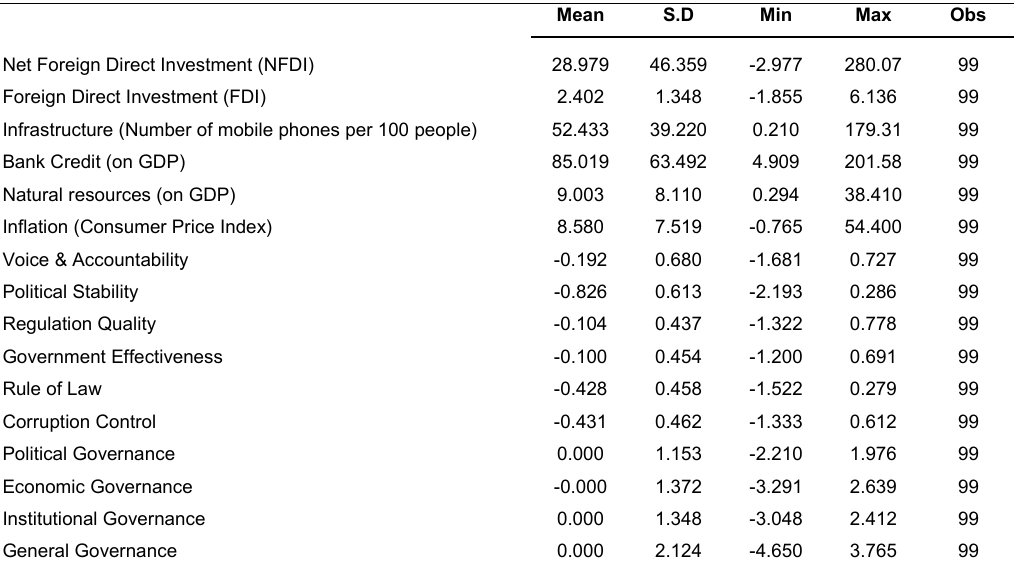
Table 3: Summary Statistics of Variables